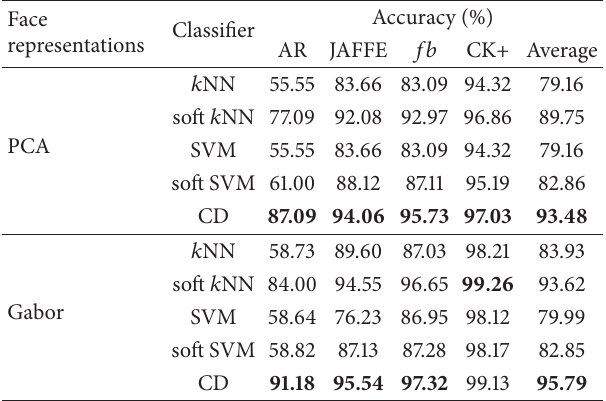
Table 4: Comparison of face recognition accuracy using CD classifier trained by 𝜏 𝑠 Prediction against several other popular classifiers.